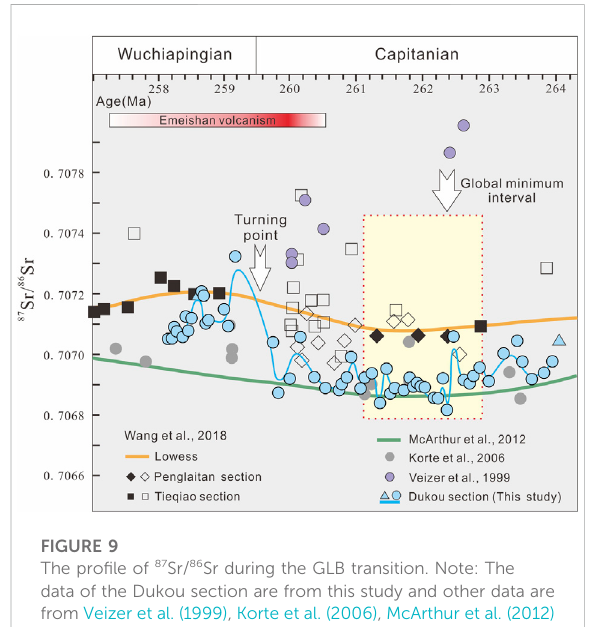
FIGURE 9 The pro fi le of 87 Sr/ 86 Sr during the GLB transition. Note: The data of the Dukou section are from this study and other data are from Veizer et al. (1999), Korte et al. (2006), McArthur et al. (2012) and Wang et al.